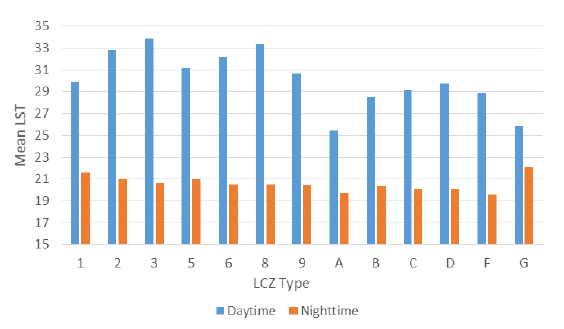
Figure 11. Mean daytime and night-time LST per Local Climate Zone in Quezon City,